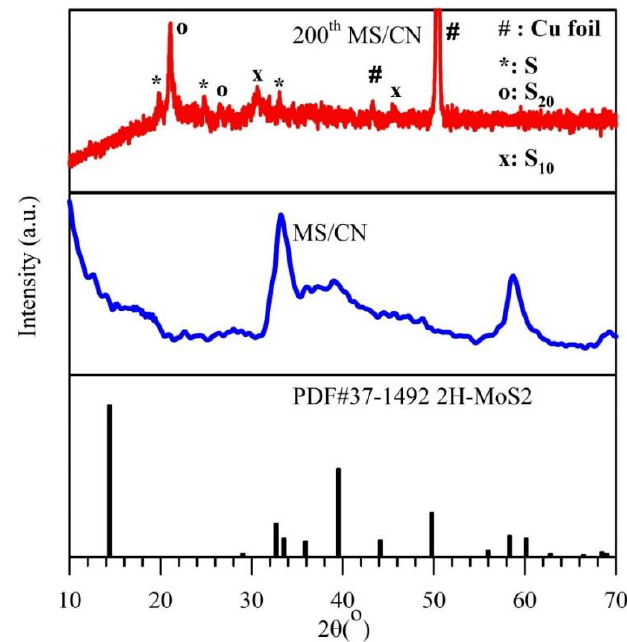
Figure 8. XRD patterns of MS/CN, MS/CN electrode after 200 cycles and reference of MoS 2 .